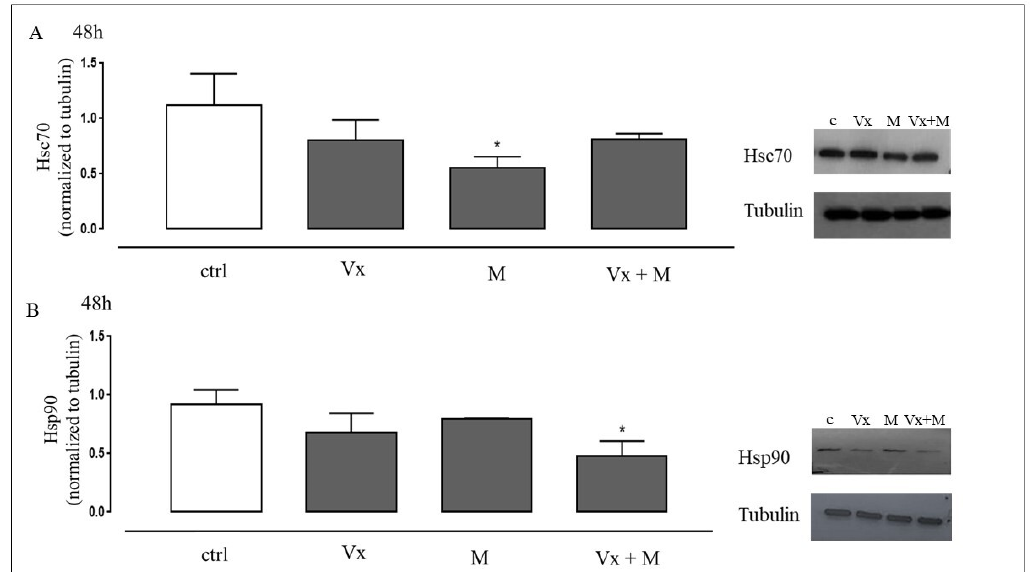
Figure 2. Vx-809 and Matrine co-treatment interferes with molecular trafficking. Vx-809 (2 µM) and Matrine (300 µM) were administered for 48h in A549 ∆ and Hsc70 ( A ) and Hsp90 ( B ) expressions were detected by Western blot analysis. Tubulin protein expression was used as loading control. Results are expressed as mean ± S.E.M. from at least three independent experiments each performed in triplicate. Data were analyzed by Mann–Whitney U test. * p < 0.05 vs. non-treated cells.